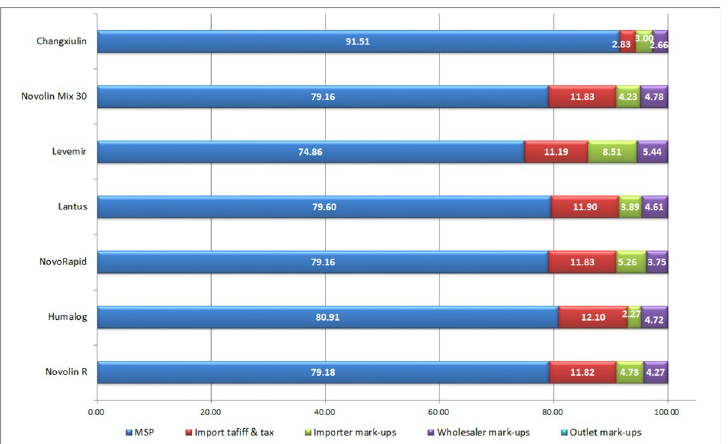
Fig 2. Insulin price components after the implementation of the bidding